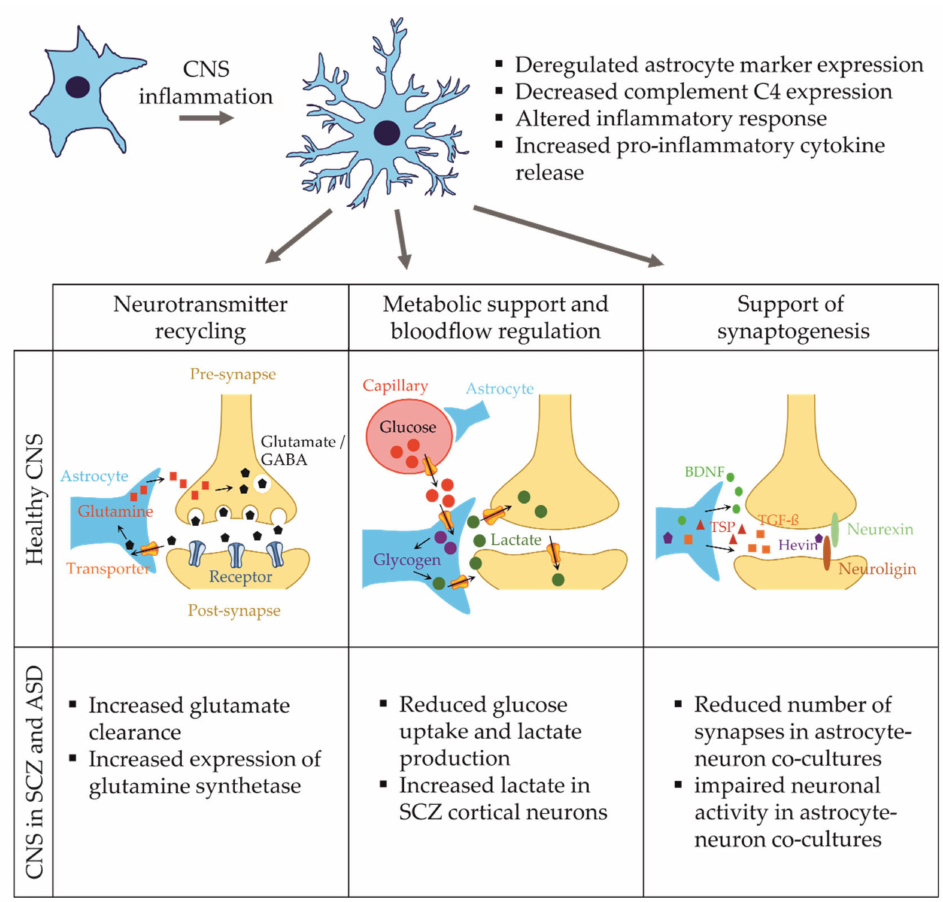
Figure 2. Overview of major astrocyte functions in the healthy brain and in neuropsychiatric disorders. Astrocytes are closely associated with pre- and postsynaptic sites, where they are involved in neurotransmitter clearance and recycling, the metabolic support of neurons, and the formation and stabilization of synapses mediated by the release of various molecules. In neuropsychiatric diseases, astrocytes are activated by inflammation and undergo changes to their morphology and expression profile, showing altered astrocytic differentiation and inflammatory responses. Consequently, these changes affect the functionality of astrocytes, ultimately leading to impairments of neuronal